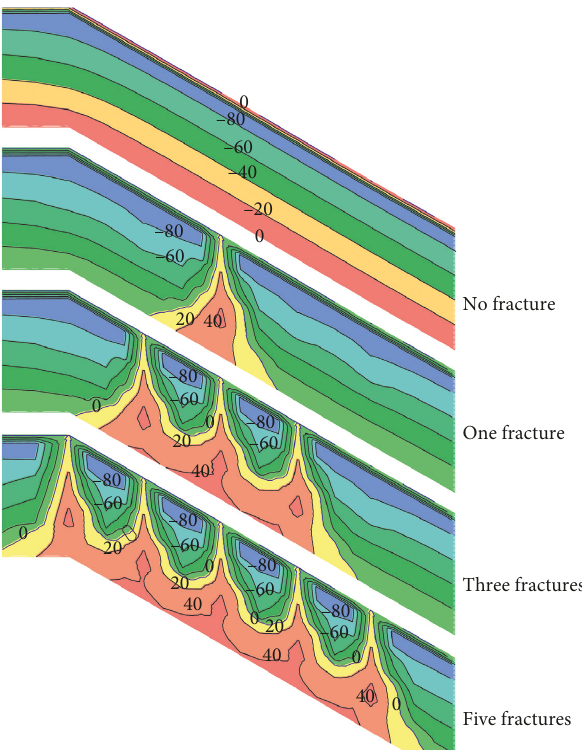
Figure 12: Effect of fracture quantity on pore water pressure field (fracture depth 3m, unit: kPa).